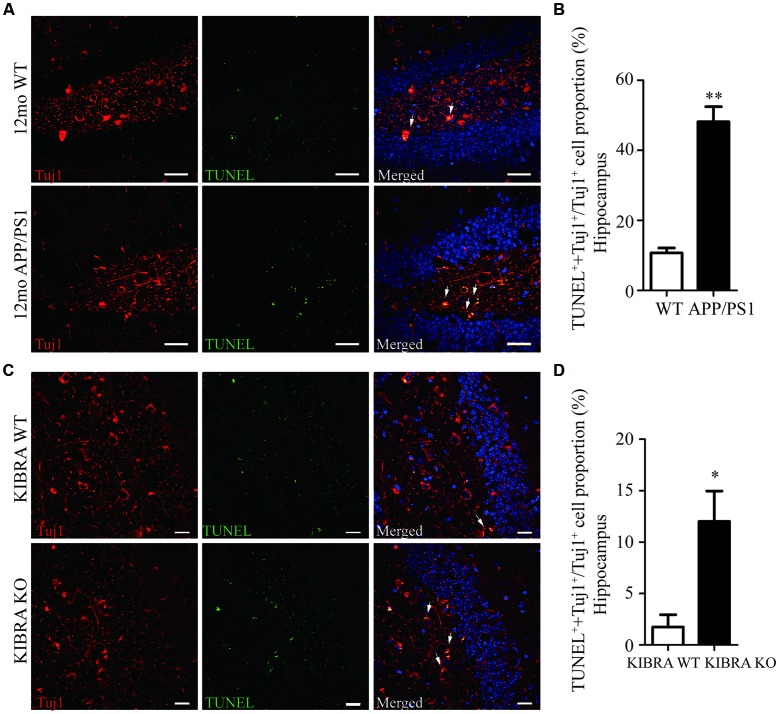
The indispensable role of KIdney and BRAin expressed protein (KIBRA) in the neuron survival. The apoptotic neurons (Tuj1, red) were analyzed by TUNEL assay (green) in APP/PS1 (A) and KIBRA KO (C) mice. Nuclei were fluorescently labeled with DAPI (blue). Compared with the wild type mice, a higher number of TUNEL positive neurons was observed in the hippocampus of APP/PS1 mice brain (B). In addition, 4-month-old KIBRA KO mice brain showed significantly increased TUNEL positive neurons (D), suggesting that KIBRA plays an indispensable role. Results are means ± SEM. (n = 5 mice in each group) from independent experiments. *p < 0.05 and **p < 0.01. Scale bar in (A) = 10 μm. Scale bar in (C) = 20 μm.